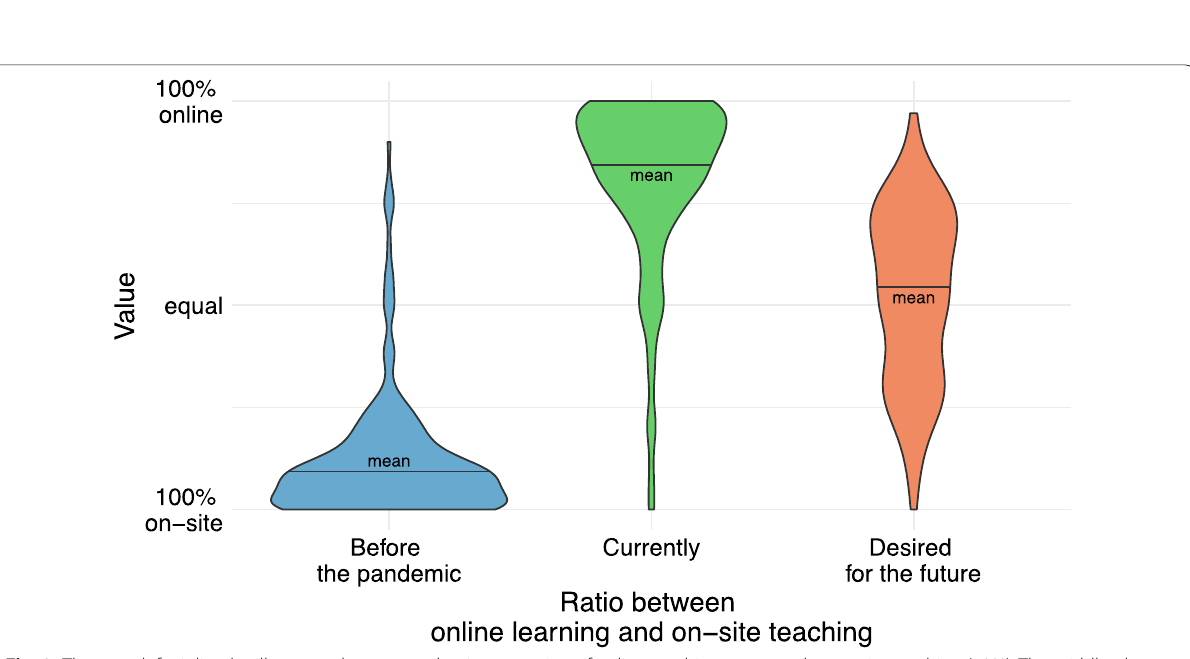
Fig. 3 The most left violin plot illustrates the pre‑pandemic proportion of online teaching compared to on‑site teaching (12%). The middle plot illustrates the current proportion of online teaching compared to on‑site teaching (81%) (status during the pandemic). The far‑right plot illustrates the proportion of online teaching compared to onsite teaching wished for the future